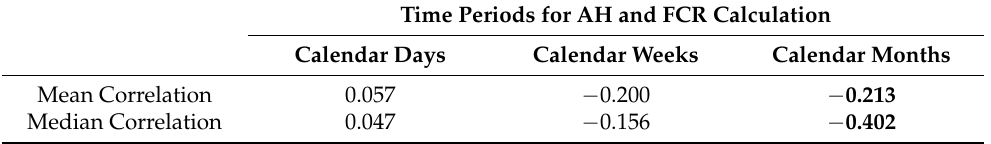
Table 1. Mean and median of correlations between AH and FCR through time for different drivers when AH and FCR are calculated for calendar days, calendar weeks, and calendar months. Time Periods for AH and FCR Calculation Calendar Days Calendar Weeks Calendar Months Mean Correlation 0.057 − 0.200 − 0.213 Median Correlation 0.047 − 0.156 − 0.402